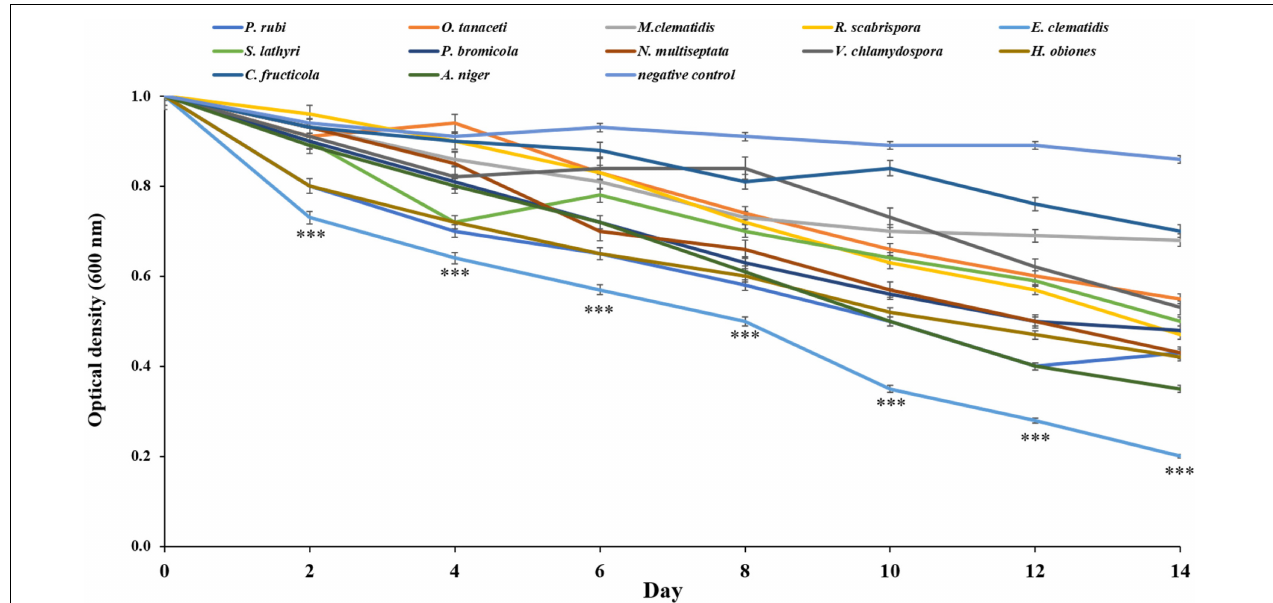
FIGURE 4 | Optical density of culture supernatant of active fungi after 2-week inoculation. ∗∗∗ Above the points indicates a significant difference ( p < 0.001) (ANOVA, followed by Dunnett’s test).